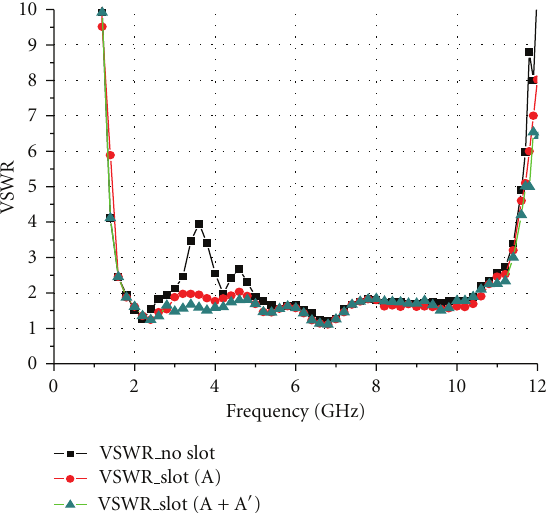
Figure 8: Measured results of the variation of VSWR of the proposed antenna.